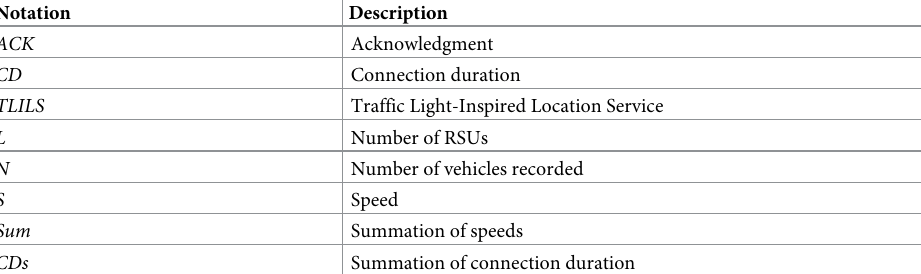
Table 3. Notations used in Algorithm 1 and their